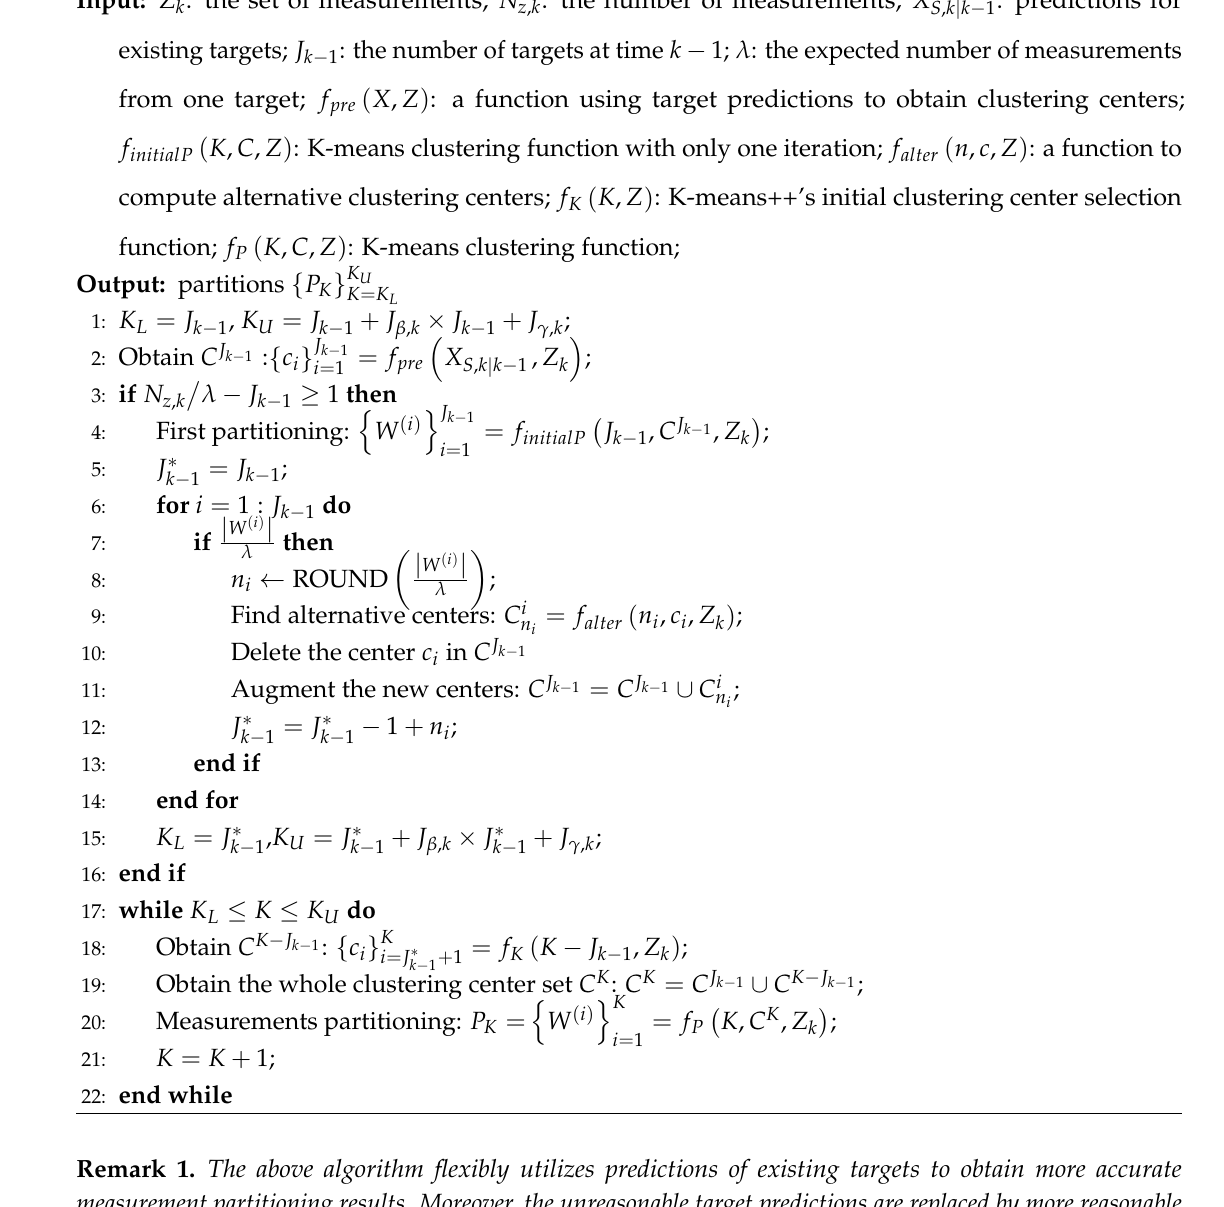
Algorithm 1 Prediction-driven measurement sub-partitioning